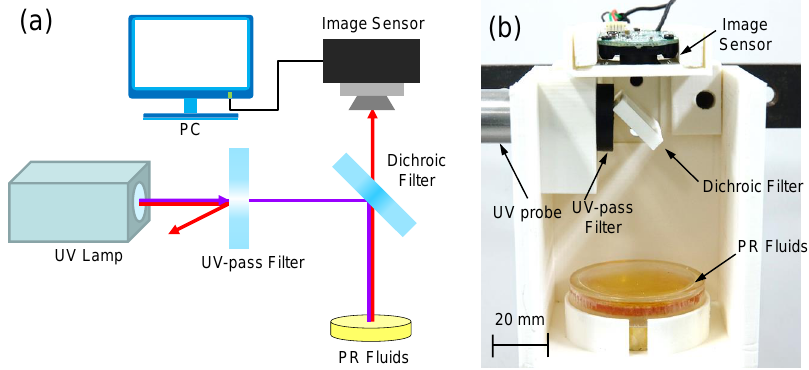
Figure 4. Experimental setup for measuring the UV light intensity: ( a ) schematic; ( b )